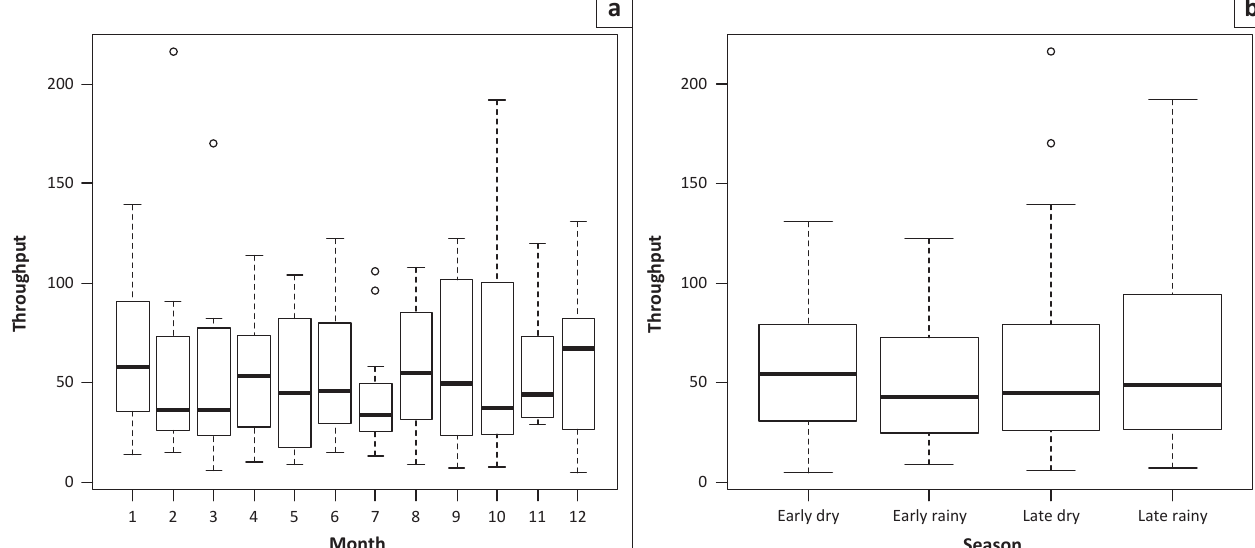
FIGURE 2-A2 continues on the next page